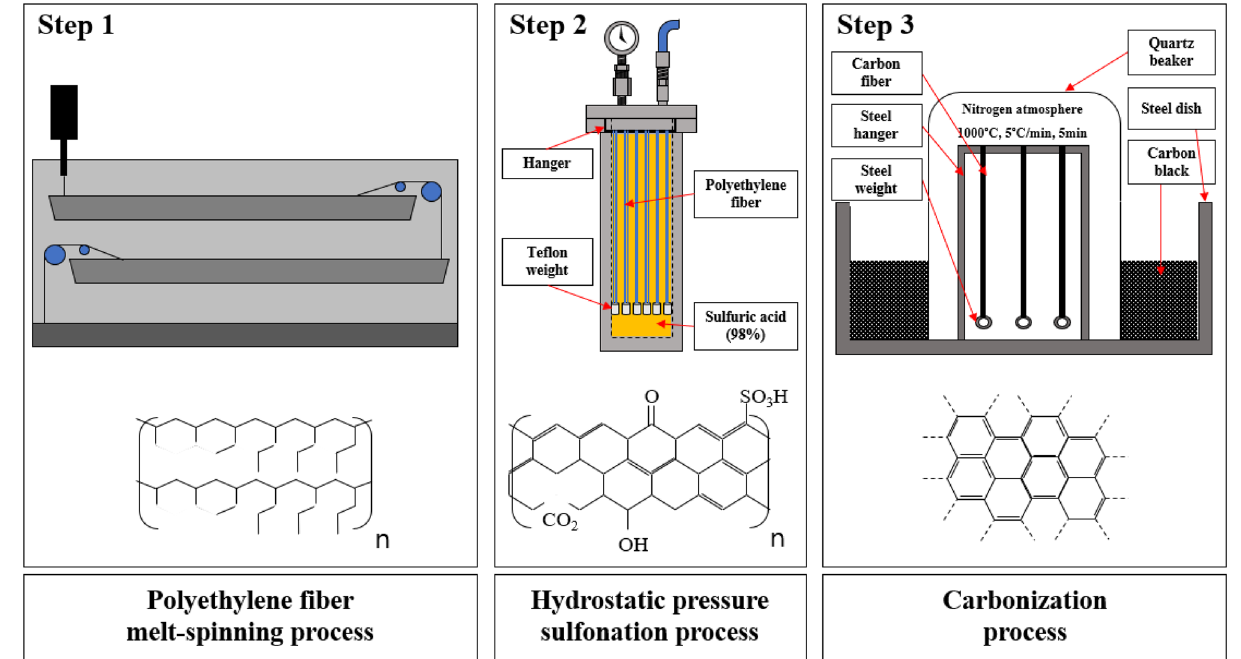
Figure 2. Polyethylene based carbon fiber flow chart and chemical